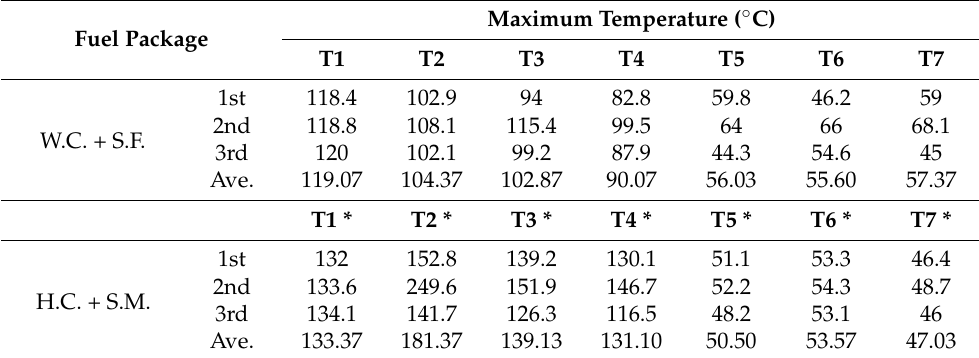
Table 3. Maximum temperatures by thermocouple position in the fire tests of the fuel packages for residential spaces and multiplexes.